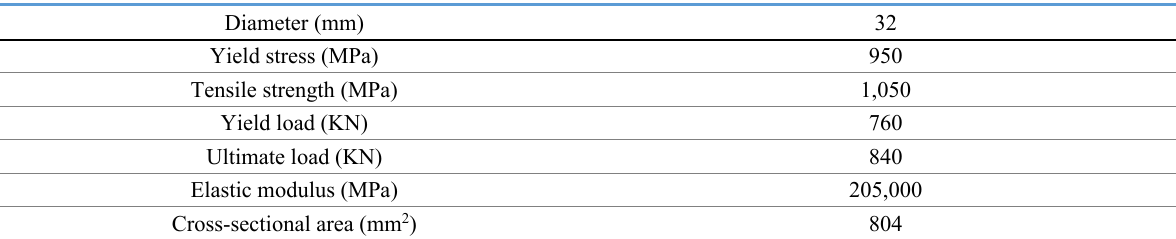
The retaining wall was anchored by two rows of ground anchors constructed with steel threaded bar tendons with 32 mm in diameter and installed in a borehole with 100 mm in diameter ( D b ). Uniaxial tensile tests were performed on the tendons in order to obtain the elastic modulus. Table 1 lists the mechanical properties of the used bar tendons. Table 1 - Characteristics of the bar